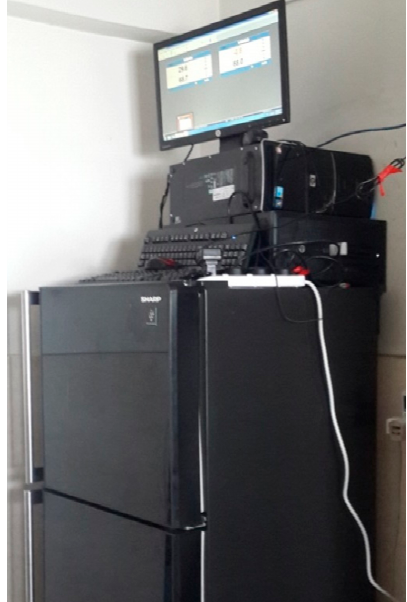
Figure 11. REF power consumption measurement.